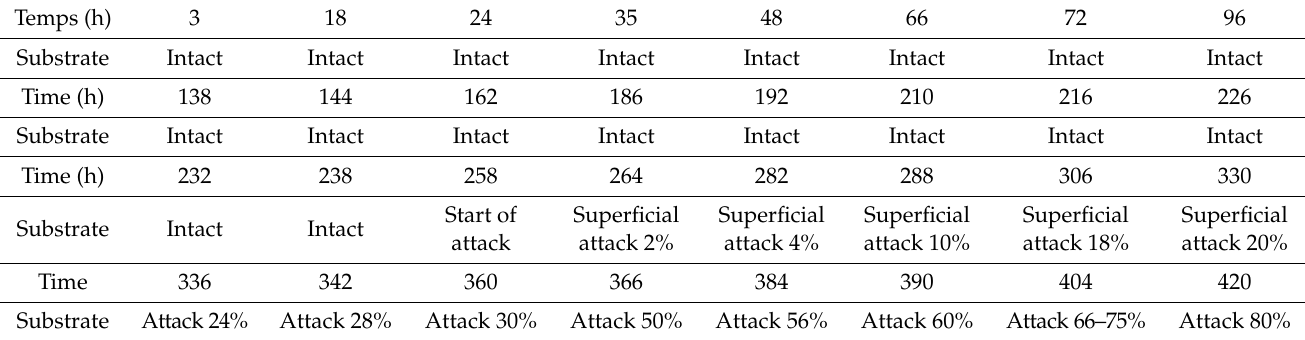
Table 6. Rate of surface damage as a function of the number of hours of exposure to salt spray